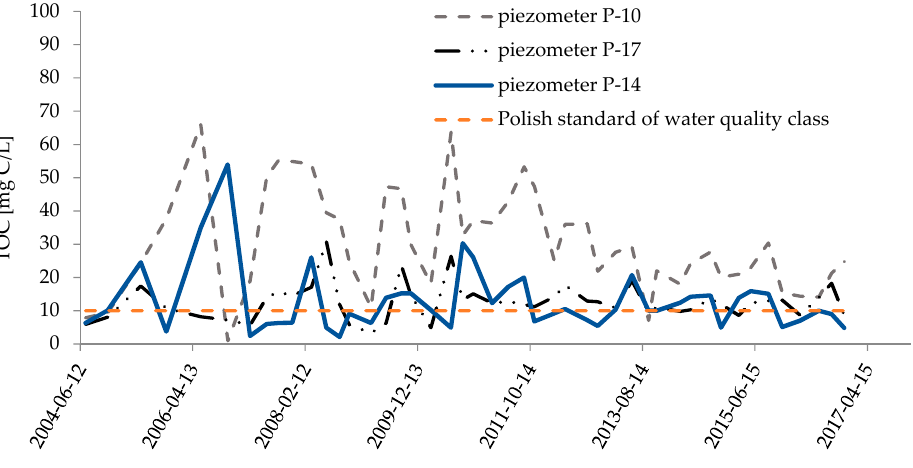
Figure 14. Temporal changes of the TOC level in piezometers located in the area of adjacent